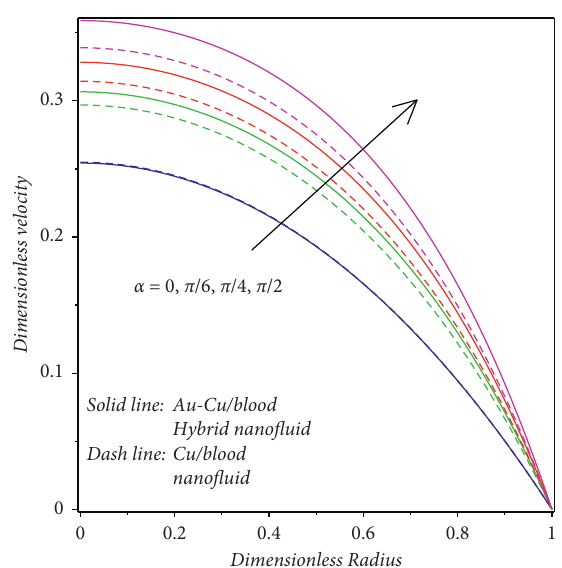
Figure 10: Behaviour of β on w